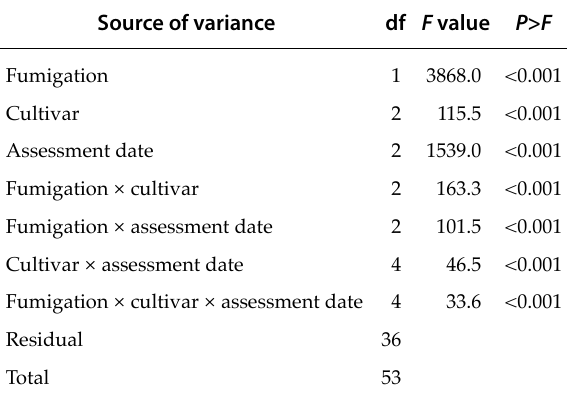
Table 3. Analysis of variance for plant decline indices (% DI) of strawberry cultivars in relation to fumigation, cul- tivar and assessment date in the field experiment in Wan - neroo, Western